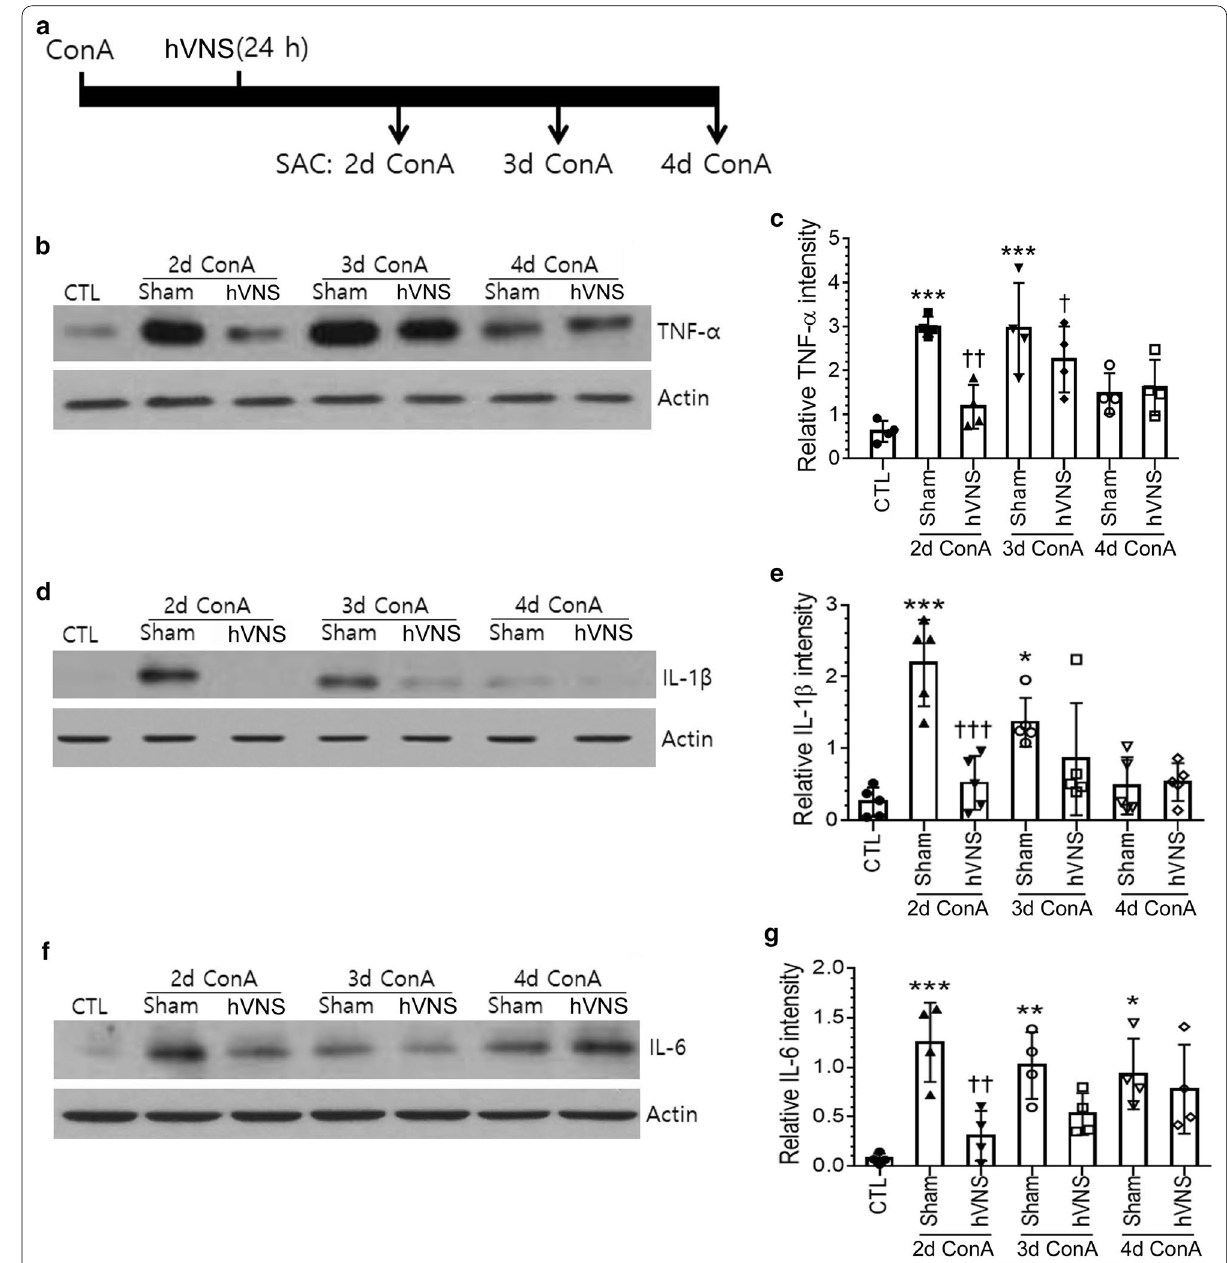
Fig. 3 Changes in inflammatory cytokine levels in the liver tissue of ConA‑injected animals at different time points after hVNS. a A schematic showing the time schedule for the treatments of ConA and hVNS and a sacrifice (SAC) of animals for western blot analysis. Animal groups are named based on the time interval between ConA injection and SAC. b , c Western blot analysis of TNF‑α for the liver lysates from individual group of animals. d , e Western blot analysis of IL‑1β for the liver lysates from individual group of animals. f , g Western blot analysis of IL‑6 for the liver lysates from individual group of animals. Images in b – f are the representatives from four to five independent experiments, and the quantifications of protein band intensity relative to actin are plotted in c , e , and g . Western blotting for actin as sample loading control. In c , e and g , one‑way ANOVA with Tukey post hoc is shown. In c , ***p < 0.001 vs. CTL, †p < 0.05 vs. 3d VNS Sham, ††p < 0.01 vs. 2d VNS Sham. In e , *p < 0.05 vs CTL, ***p < 0.001 + + vs. CTL, †††p < 0.001 vs. 2d VNS Sham. In g , *p < 0.05 vs. CTL, **p < 0.01 vs. CTL, ***p < 0.001 vs. CTL, ††p < 0.01 vs. 2d VNS + +